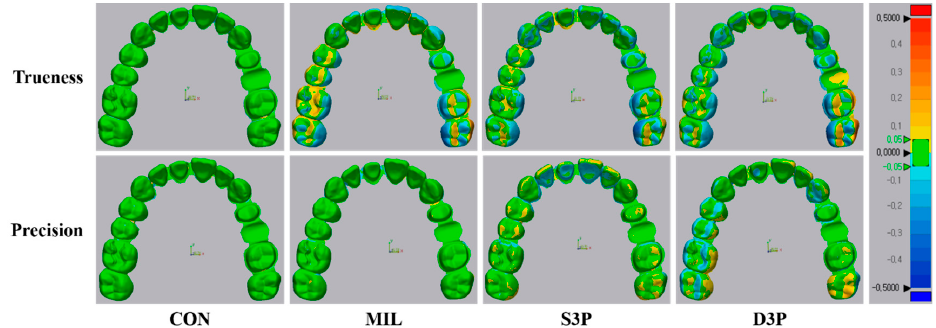
Figure 3. Qualitative analysis of accuracy (trueness and precision) of full arch situation in tested group. CON, conventional gypsum model; MIL, milled gypsum model; S3P, SLA 3D printed photopolymer model; D3P, DLP 3D printed photopolymer model.